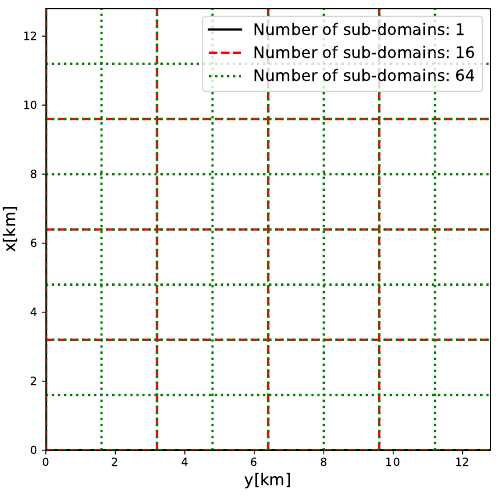
Figure 2. Example of sub-domains construction.